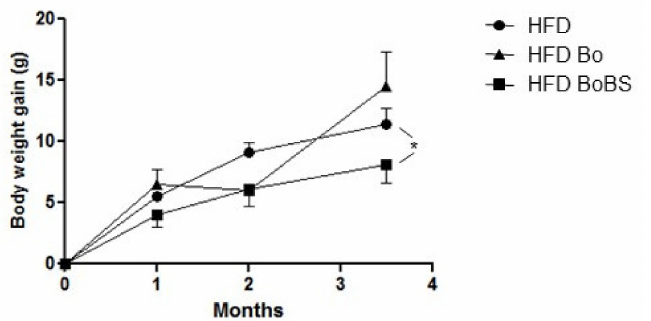
Figure 1. Carrot supplementation effects on body weight gain of ApoE − / − mice. Time course of body weight gain in mice fed with HFD (black circle, n = 8; 4 males and 4 females) or HFD containing Bolero under standard condition (Bo, black triangle, n = 7; 5 males and 2 females) or Bolero under biotic stress condition (BoBS, black square, n = 6; 4 males and 2 females) for 14 weeks. Data were given as mean ± SEM. * p < 0.05 vs., HFD group.